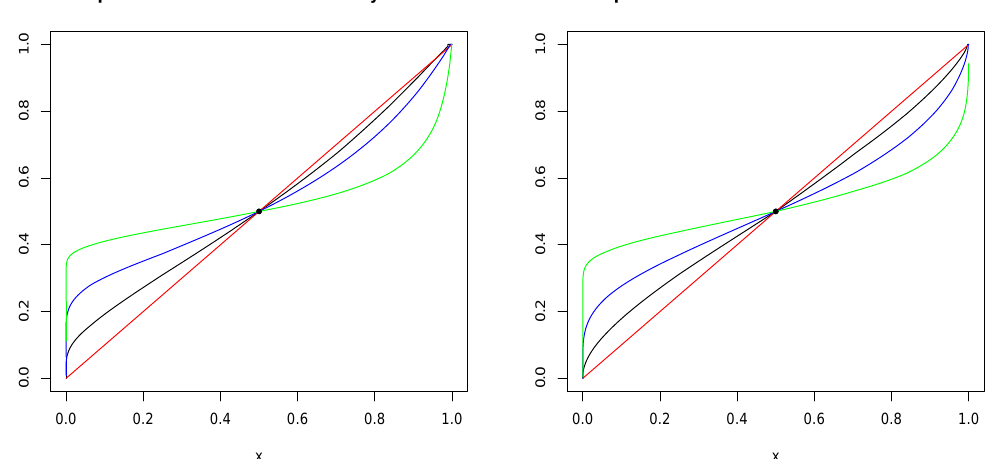
Figure 3. Non-parametric b T ( x ) as in Definition 4.3 estimated on a sample of size n = 1500 . Bivariate Clayton-case (left) and bivariate Gumbel- case (right) with Kendall’s τ = 0 . 25 (black lines), τ = 0 . 5 (blue lines), τ = 0 . 75 (green lines). The red line represents the bisectrix of the